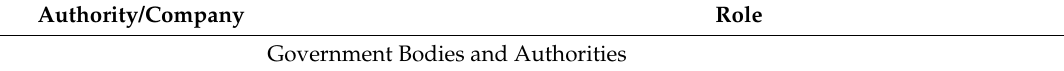
Table 4. Algerian primary energy stakeholders